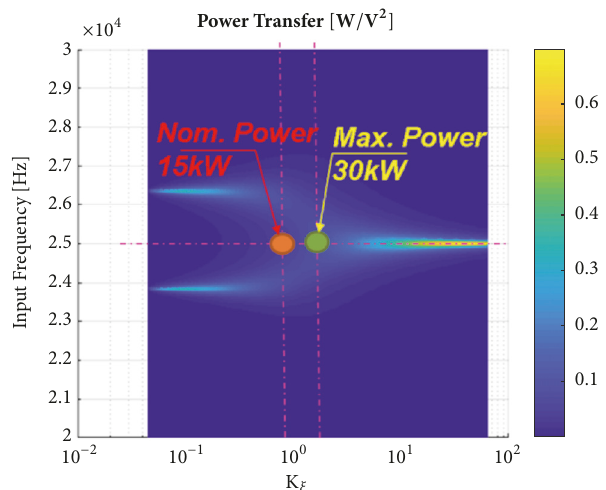
Figure12:Differentworkingconditionsoftheproposedequipment.